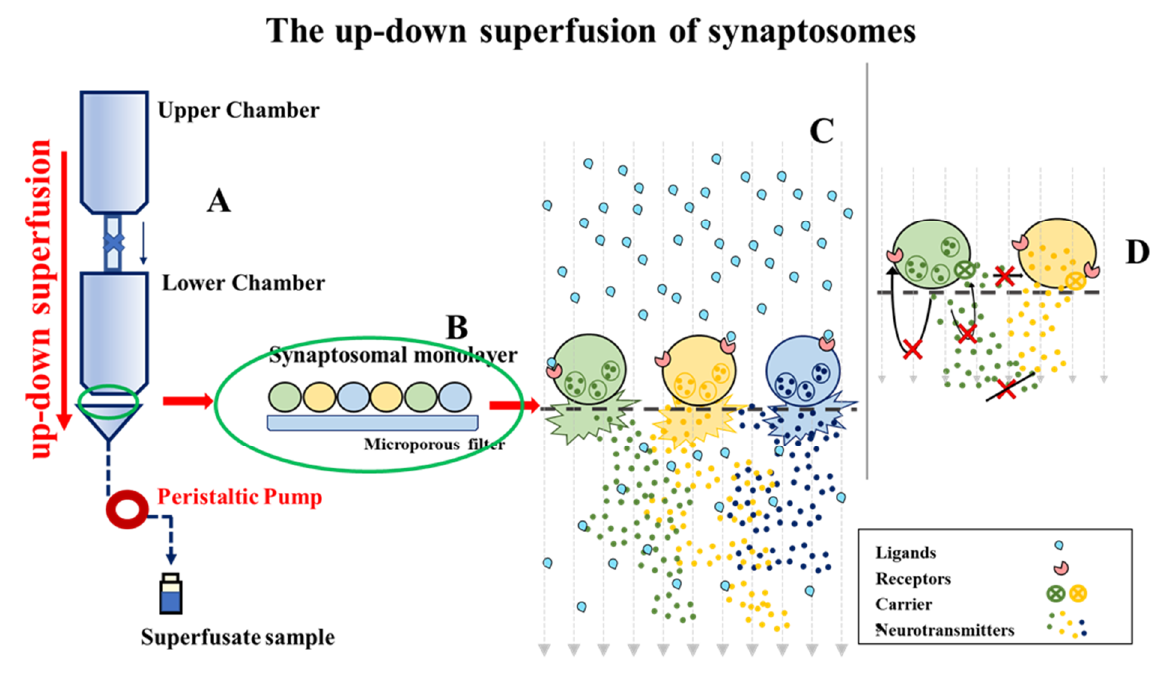
Figure 2. The superfusion apparatus (see text) [54,55].